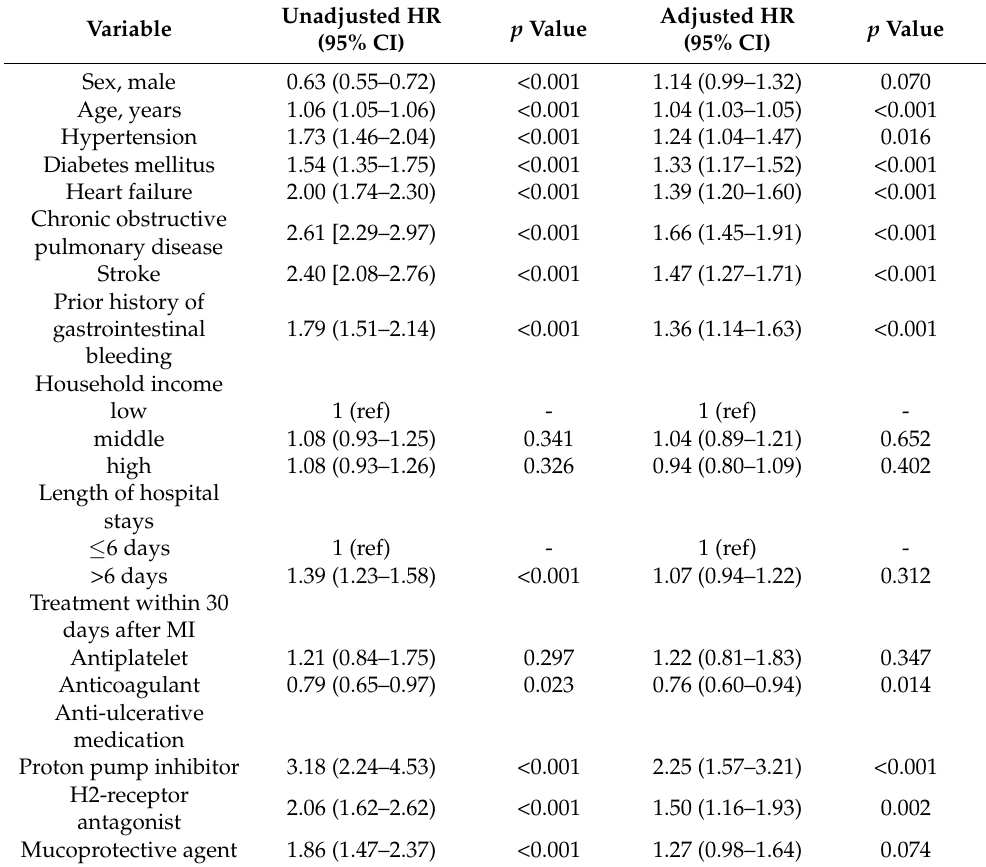
Table 2. Risk factors for the development of post-myocardial infarction